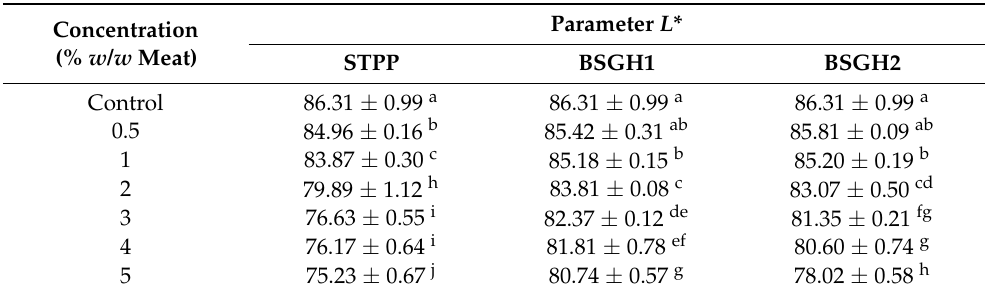
Table 2. Average values of the color parameter L * for STPP, BSGH1, and BSGH2. Results are presented as the average of three replicates ± standard deviation. Different letters indicate significant differences ( p ≤